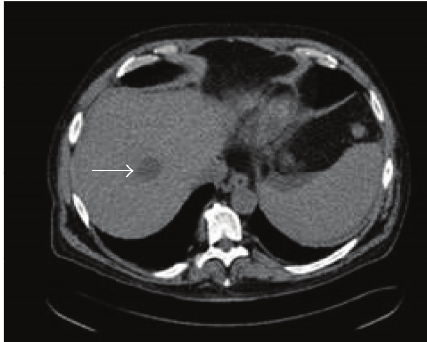
Figure 3: CT image on day 14 redemonstrated enlarged ill-defined hypodensity within the right hepatic